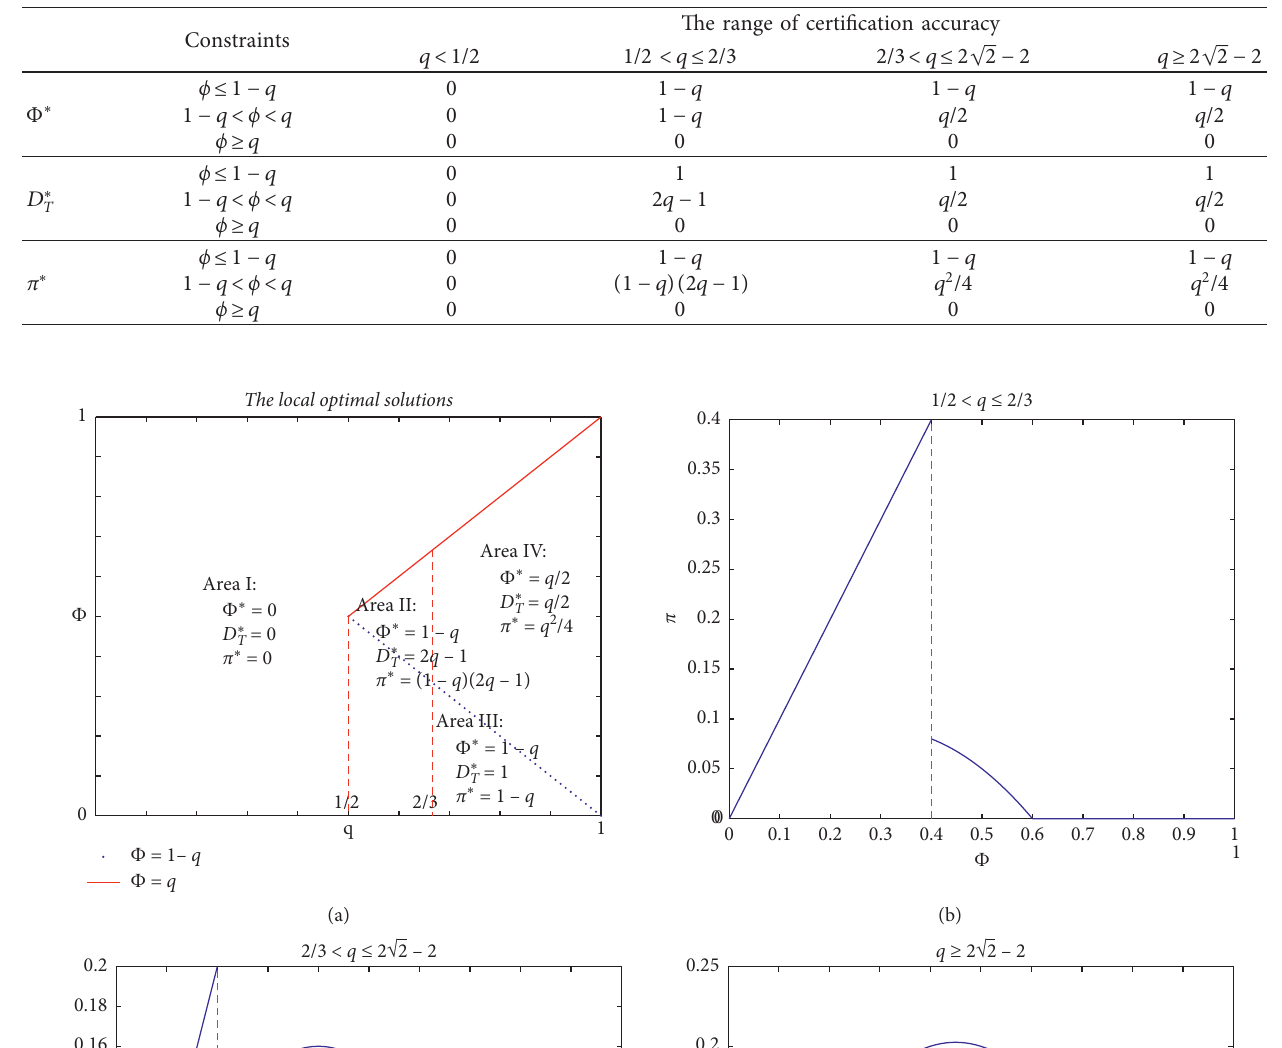
� √ − 2; (d) in the situation of 2 2